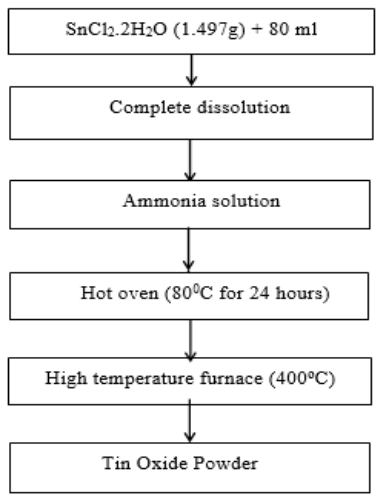
Figure 1. Synthesis process flow of SnO 2.